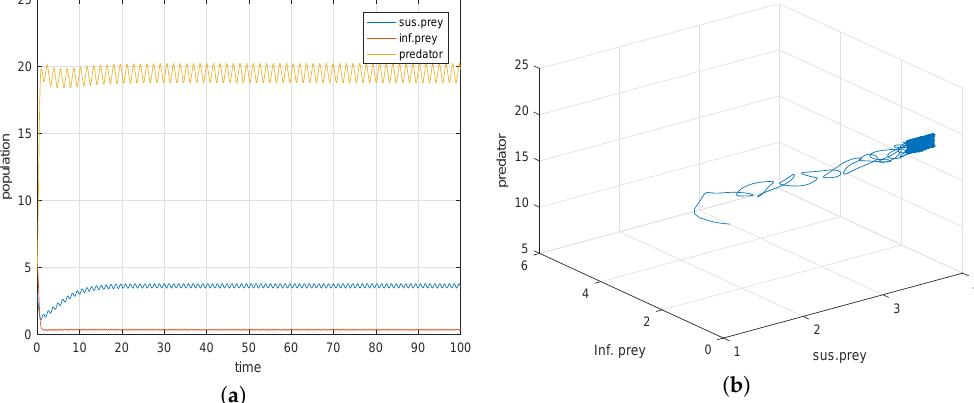
Figure 5(a) represents the variations of populations against time with the parameters α = 1 ,α 2 = 2 ,α 3 = 3 . Figure 5(b)represents the phase portrait diagram of prey and predator under random noise with the parameters α = 1 ,α 2 = 2 ,α 3 = 3 . Figure 5. ( a ) the oscillations of populations against time with low intensities (low noise) of parameters α 1 = 1, α 2 = 2, α 3 = 3; ( b ) the phase-portrait diagram of populations under random low noise of parameters α 1 = 1, α 2 = 2, α 3 = 3.